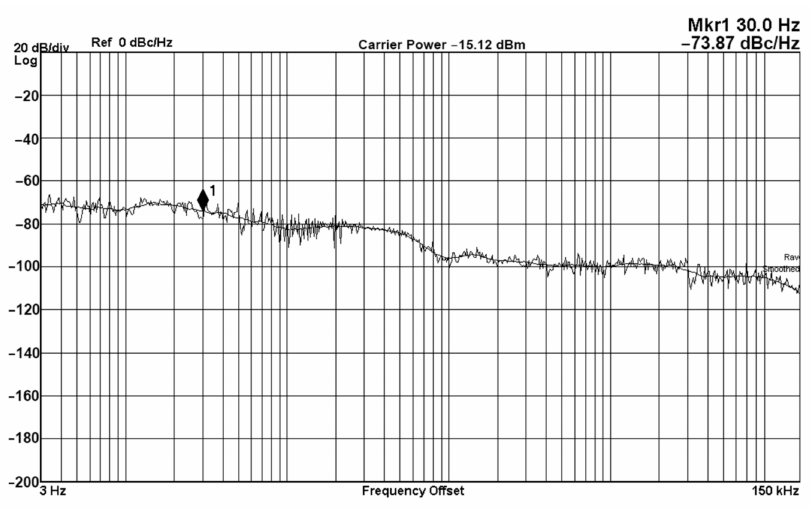
Figure 40. The measured phase noise performance of the NBPF at V BP5